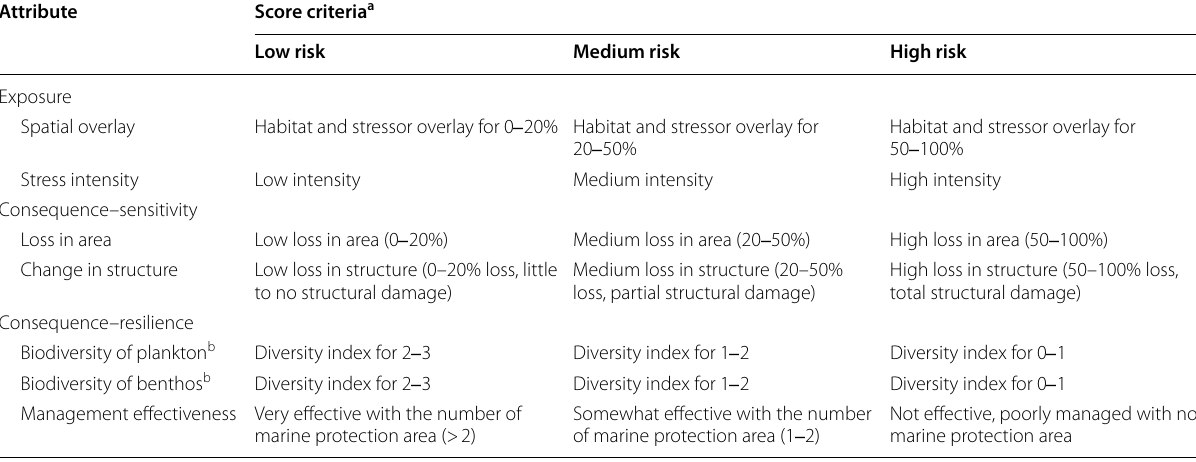
a Indicates that the scoring criteria is in accordance with Sharp et al. (2018) b Indicates that the scoring criteria is in accordance with the PRC National Standard (2008)